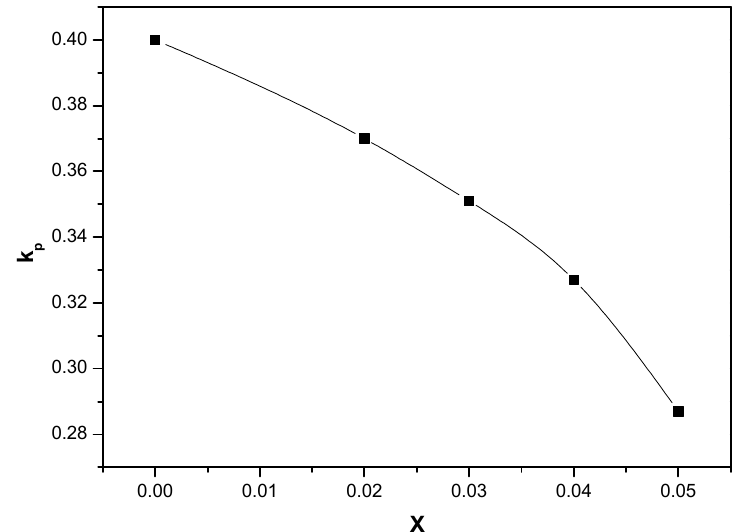
Figure 4. Electromechanical coupling factor (k p ) of specimens with x.